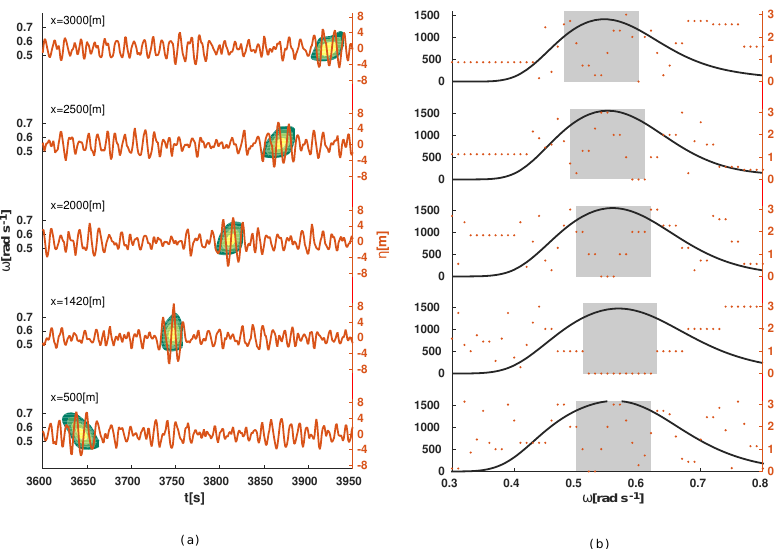
Figure 13. Case W100. (a) Time signals at various positions of the evolution of the critical group event with the filled contour plot of wavelet spectra. (b) The corresponding time-averaged wavelet spectra (solid line) and the time spreading (dotted line). Observe that at x = 1420m the time spreading is zero in the shaded area. The shaded areas show the chosen frequency interval of the most energy-carrying modes.